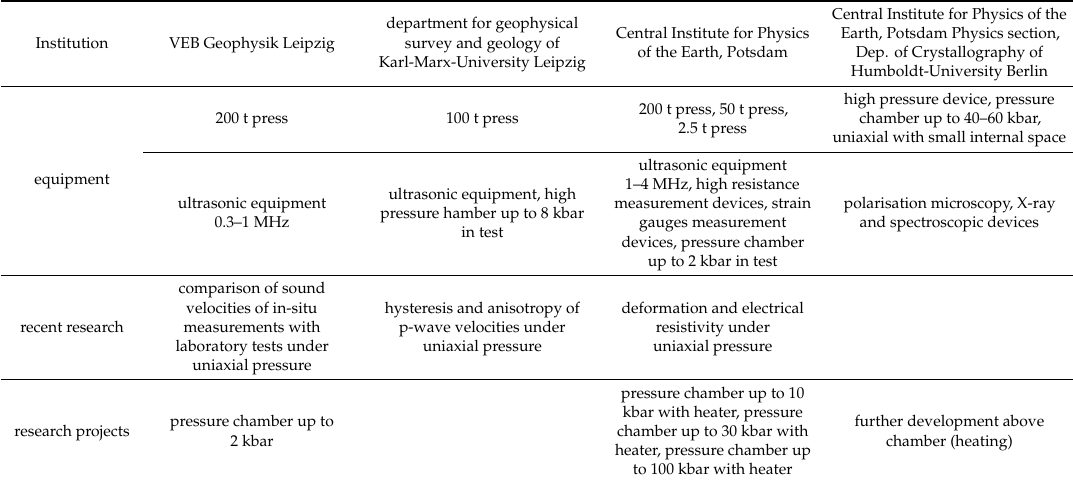
Table 1. The status of high pressure research at di ff erent institutions of the German Democratic Republic (GDR) in